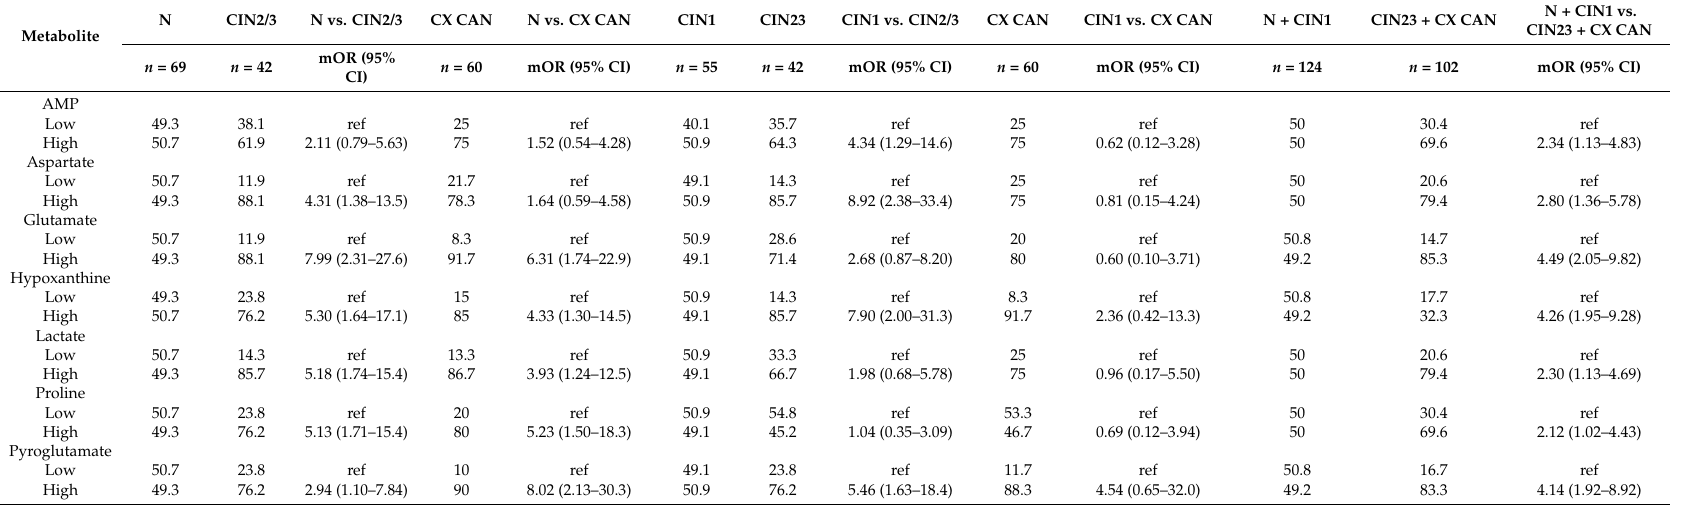
Table 3. Associations of targeted metabolites with CIN2/3 and cervical cancer